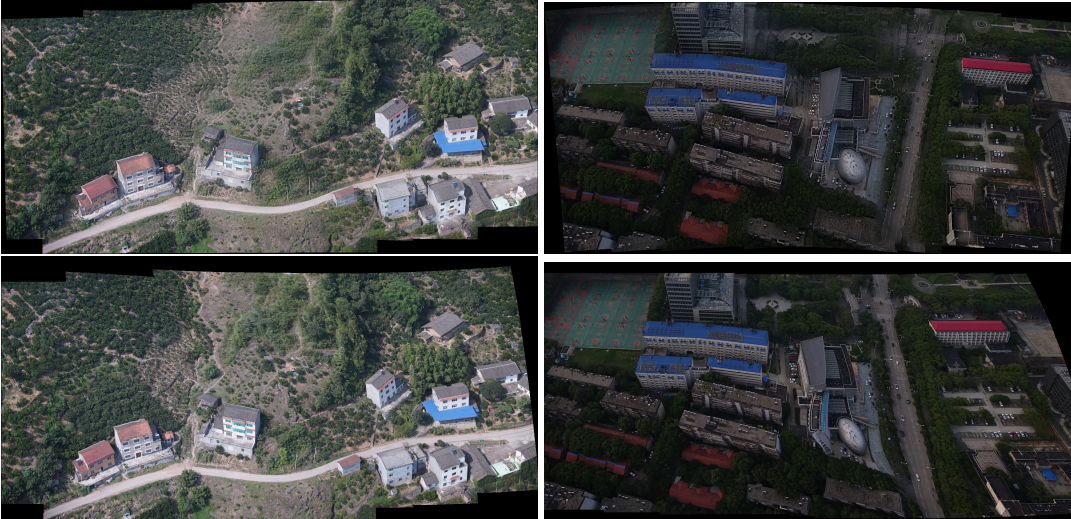
Figure 7. Experimental results of panoramic stitching. The source images are sequential images captured from left to right without nonrigid changes and parallax. The first row is the results of Autostitch. The second row is the results of our